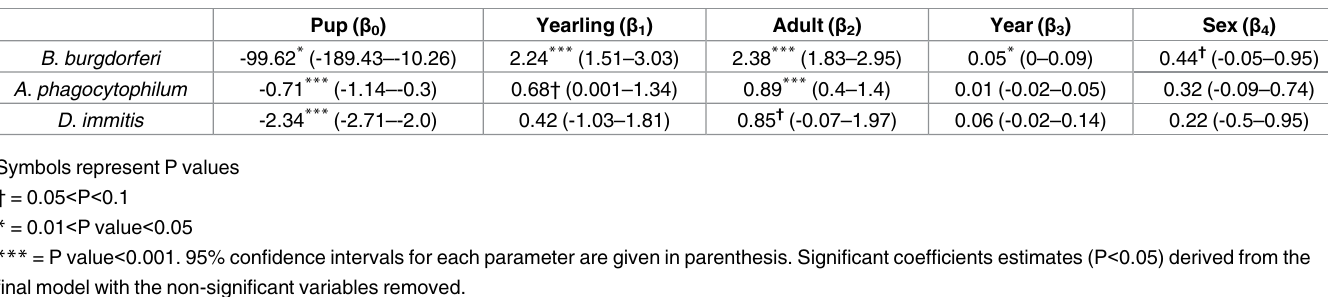
final model with the non-significant variables